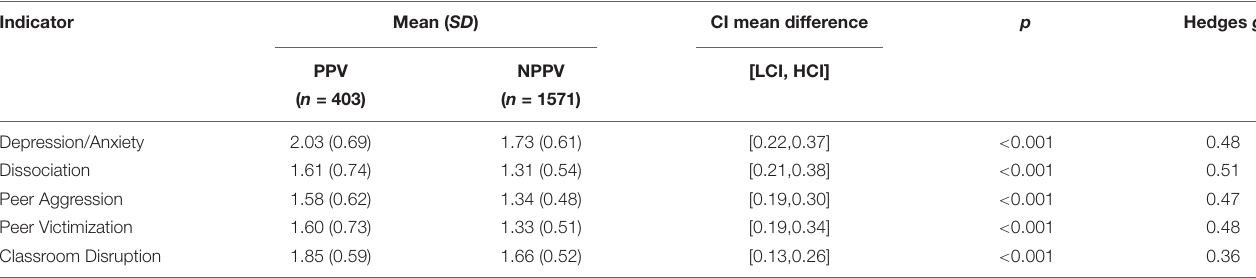
TABLE 1 | Descriptive statistics of indicators for PPV and NPPV groups. Indicator